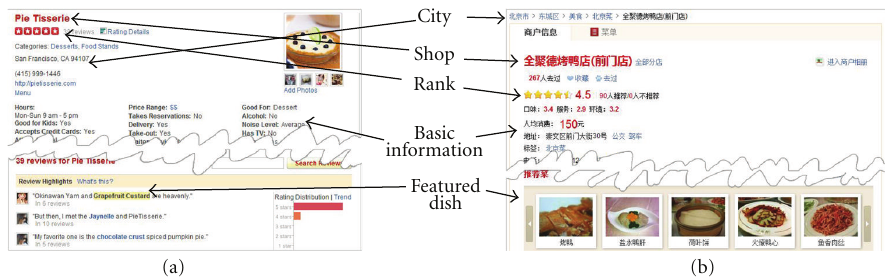
Figure 1: Example of local review websites. (a) Yelp, (b) Shenbian.